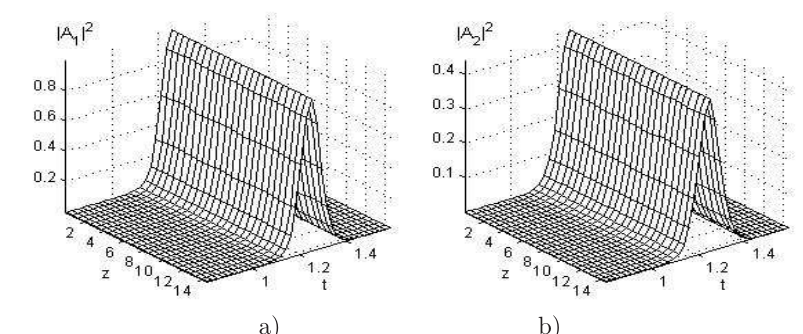
Figure 1. Evolution of solitary waves on fundamental (a) and doubled (b) frequency corresponding to the first eigenvalue for the following set of parameters: δ α = 0 ,δ γ = 1 ,n γ = 1 ,L z = 15